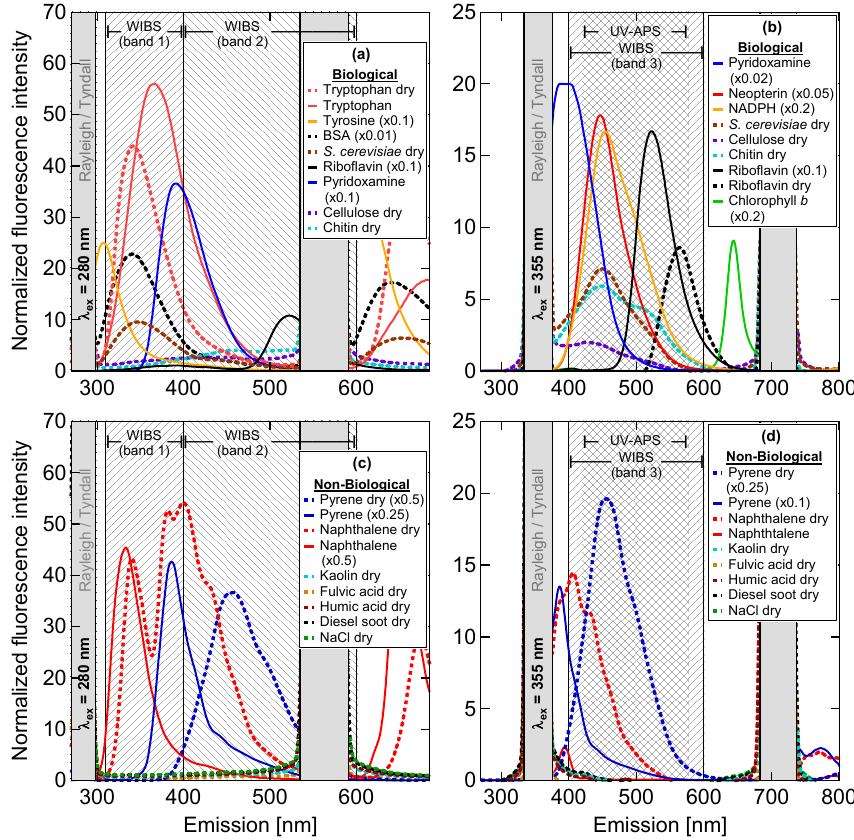
Fig. 6. Normalized fluorescence emission spectra of biofluorophores and potential interferences for selected excitation wavelengths λ ex ; (a) emission spectra of biological fluorophores at λ ex =280nm; (b) emission spectra of biological fluorophores at λ ex =355nm; (c) emission spectra of potential interferences at λ ex =280nm; (d) emission spectra of potential interferences at λ ex =355nm. Dashed lines indicate samples in dry state, solid lines indicate samples in solution. Spectra were scaled in some cases to fit on same y-axis. For example, pyridoxamine in (a) peaks at ∼ 350a.u., and not ∼ 35a.u. as